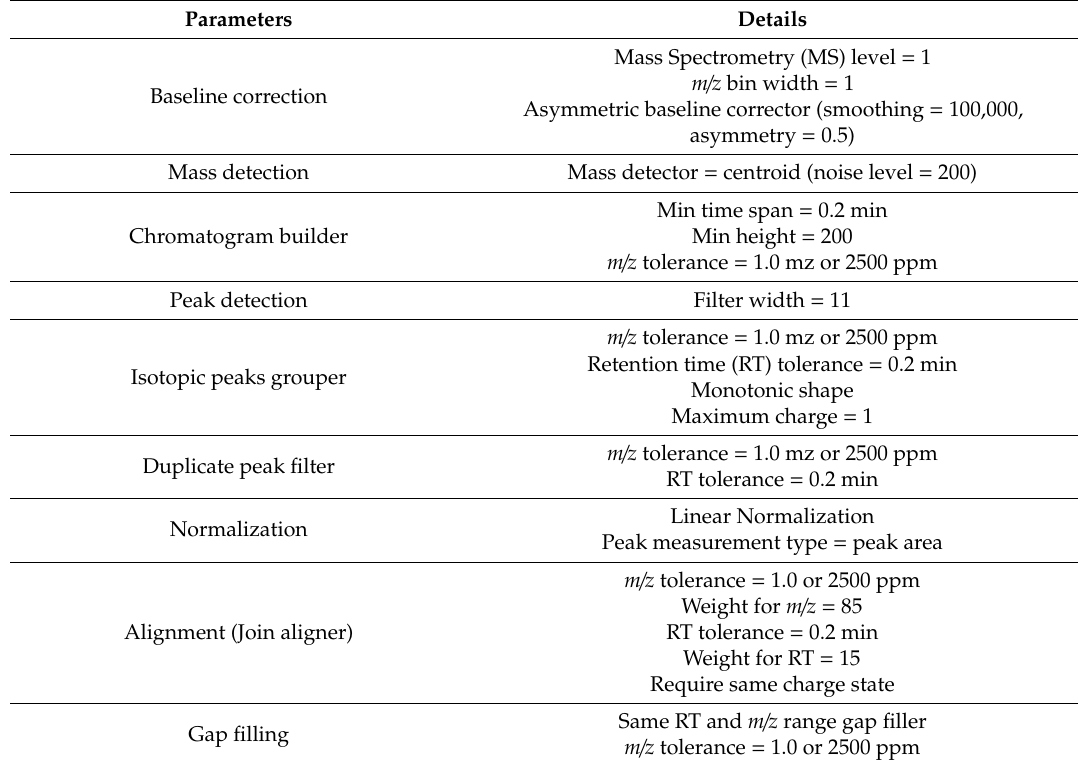
Table 4. Parameter setting for pre-processing of LC-MS data using MZmine software (VTT Technical Research Centre,